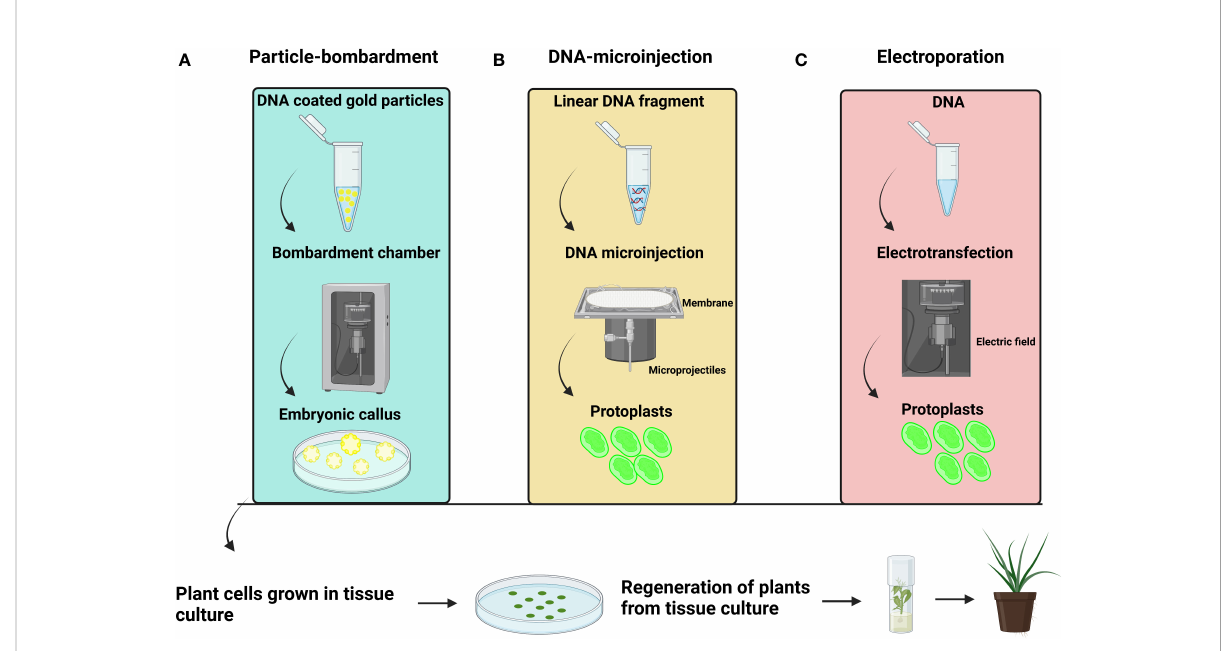
FIGURE 4 General representation (A) Particle bombardment-mediated transformation (B) DNA microinjection-mediated transformation (C) Electroporation-mediated